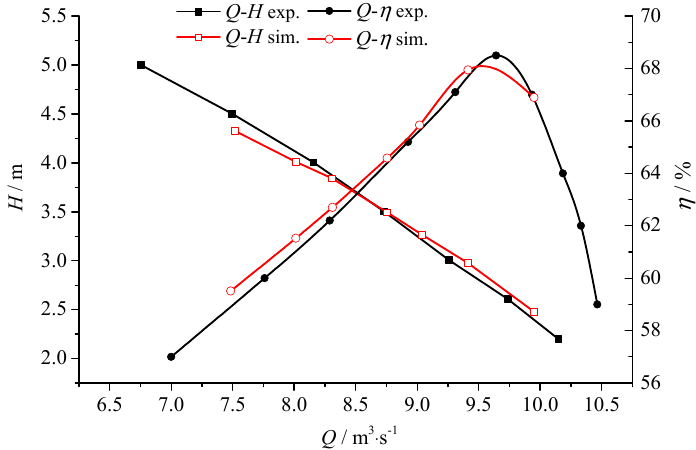
Figure 4. Comparison of numerical data and experimental data of hydraulic performances.